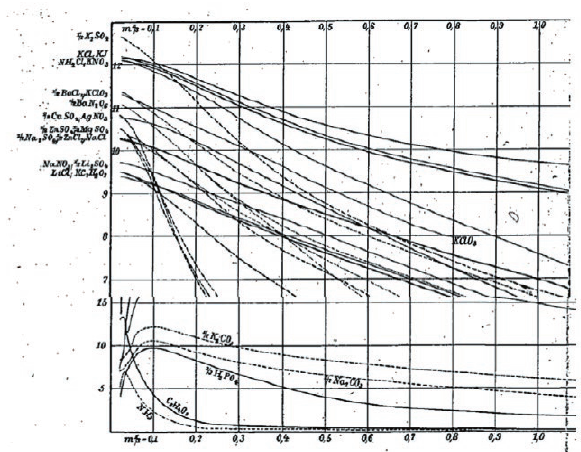
Figure 5. Equivalent conductivity (“specific molecular conductiv- ity”) as function of the cubic root, m 1/3 , of the equivalent concen- tration, m . The figure shows the left sectors of the total plot, that between zero and 1 equ.L -1 concentrations. The curves were drawn exactly through the measured values. Upper scale, strong electro- lytes, e.g. KCl , KClO 3 , etc. Lower scale, concave two lowest curves: weak electrolytes acetic acid, NH 3 . Modified; from ref. [132] , Plate II, after p. 648.